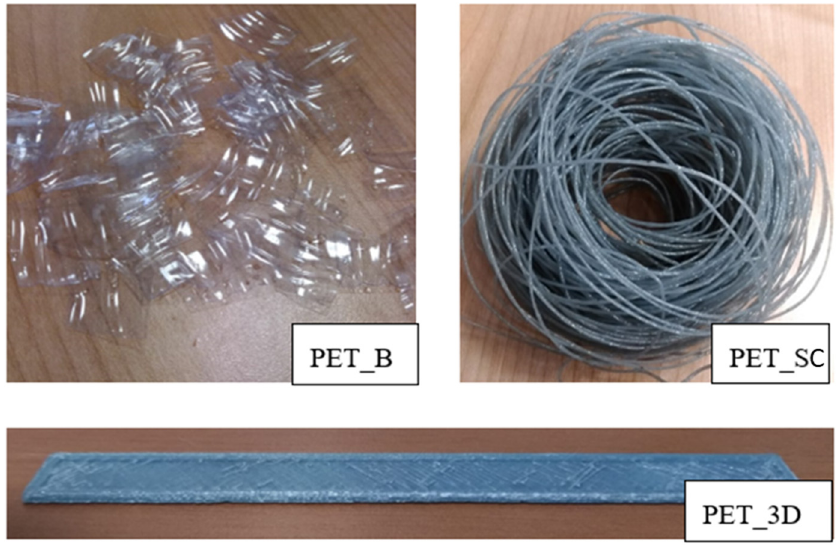
Figure 1. Di ff erent processing steps from PET flakes to PET wire and PET 3D Figure 1. Different processing steps from PET flakes to PET wire and PET 3D sample.